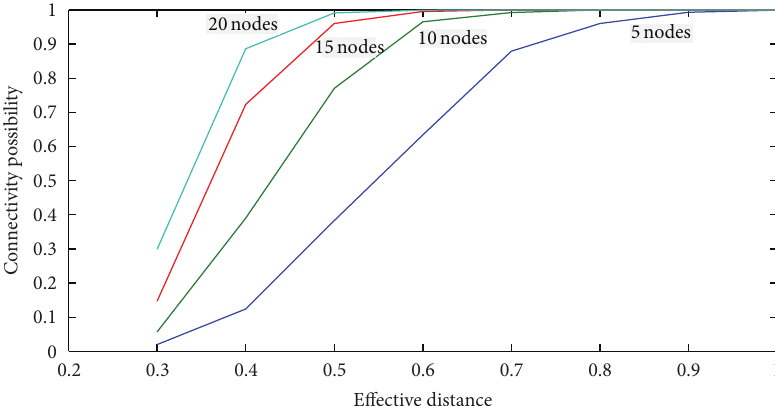
Effective distance Figure 5: The relationship between density and connectivity.